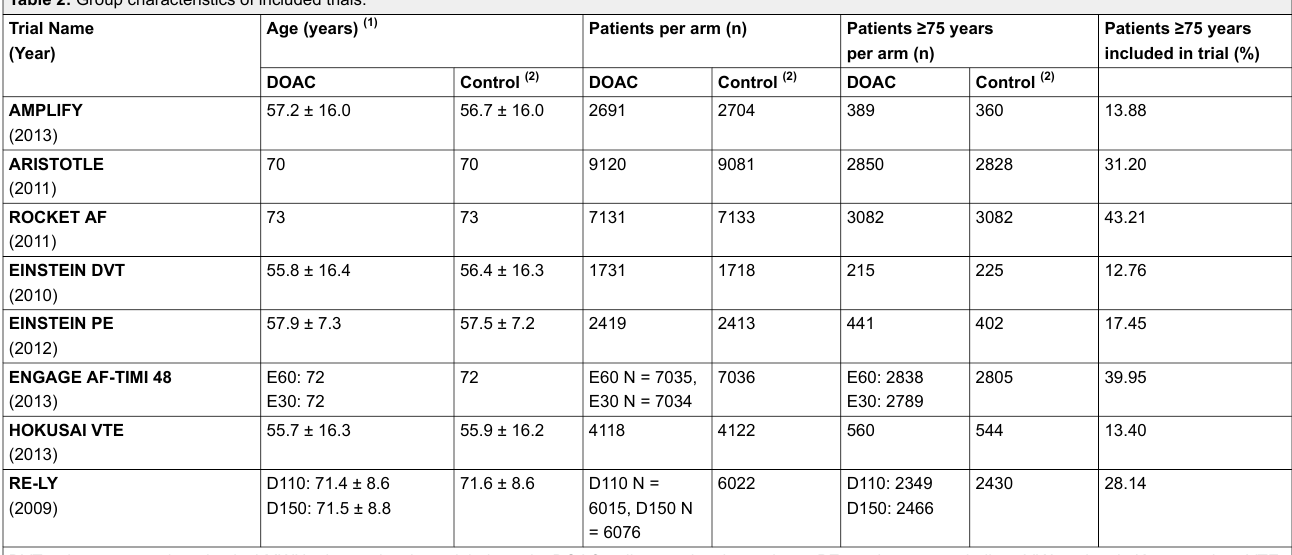
Table 2: Group characteristics of included